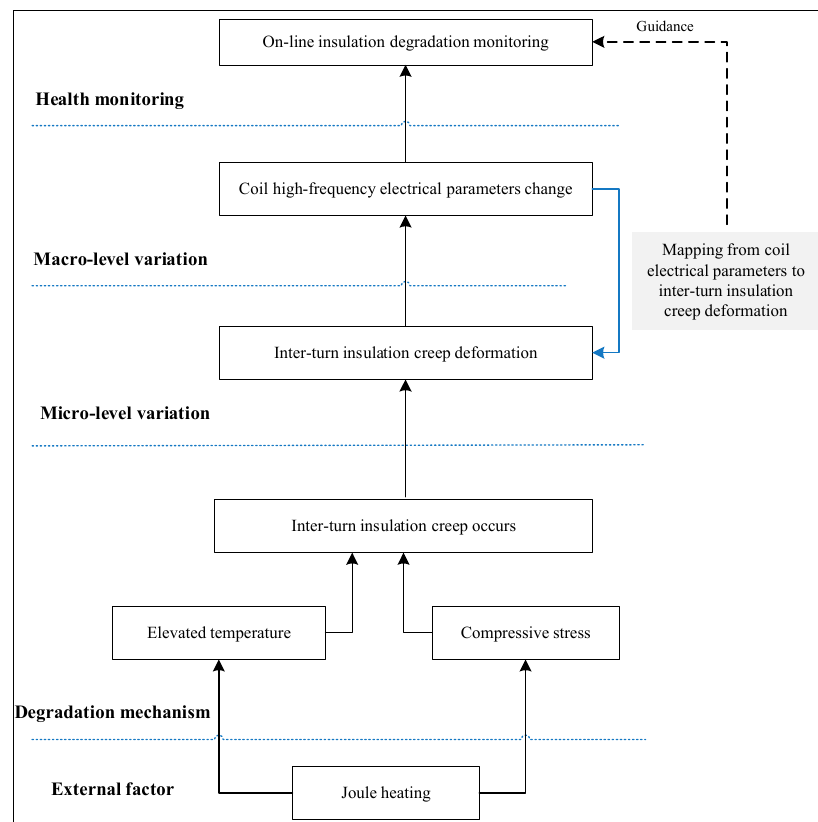
Figure 3. Framework for coil insulation degradation monitoring from a creep point of view developed in this